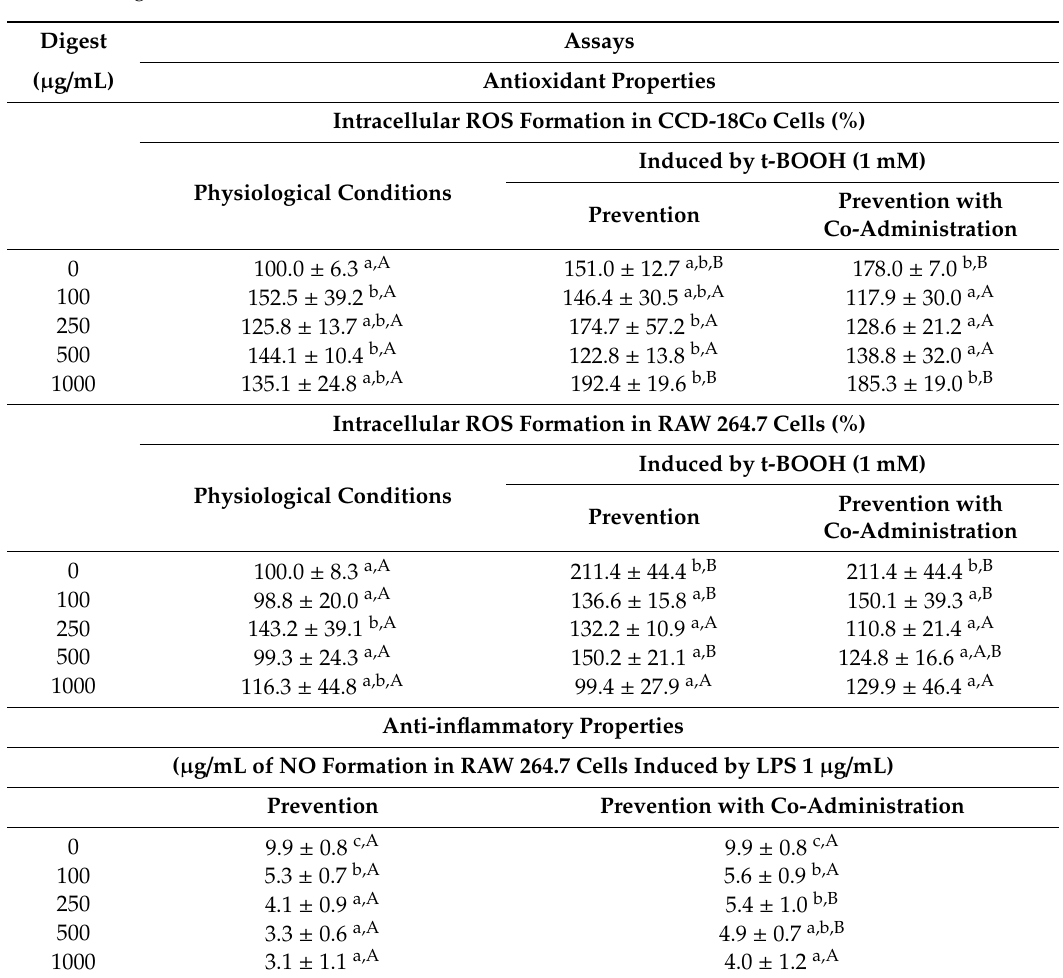
Figure 1. In vitro antioxidant capacity of the extract and the digest determined by ABTS and ORAC. Different letters indicate significant differences (Tukey test, p < 0.05) between values in the same assay. Table 2. Bioactive properties of bioaccessible compounds from Tannat grape skin hydro-alcoholic-acid extract